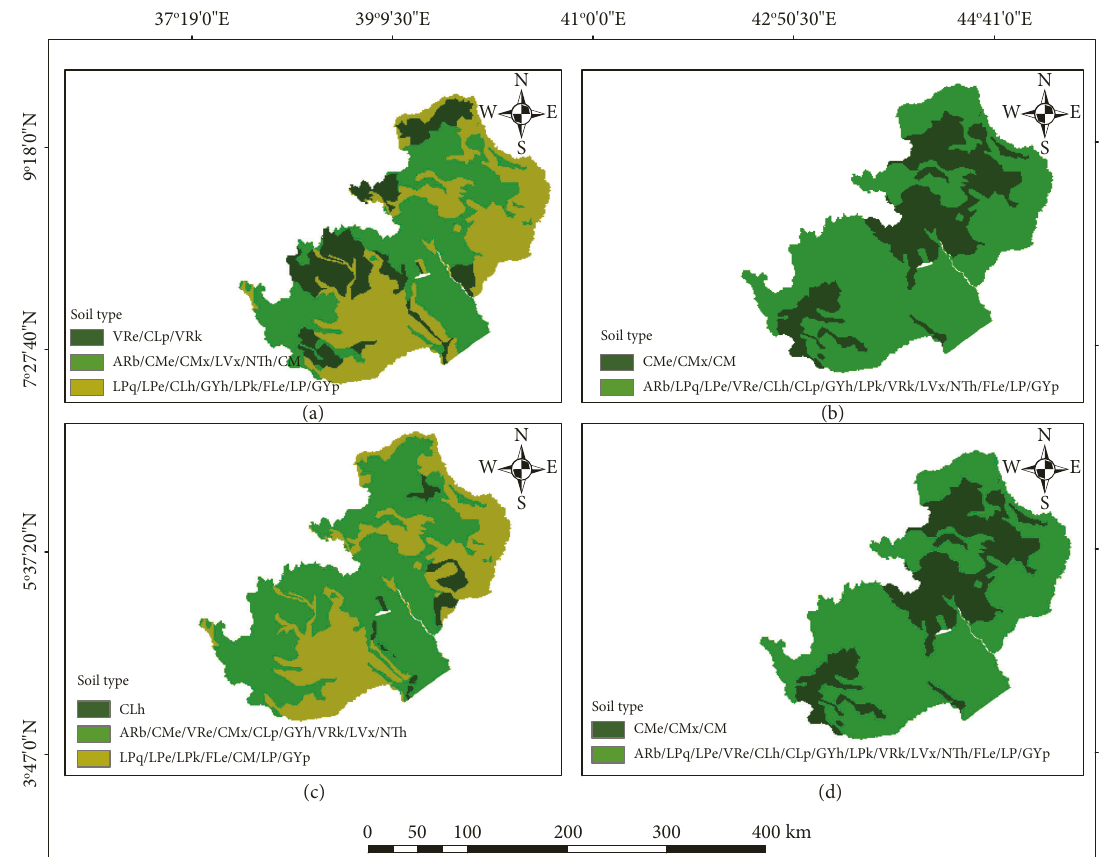
Figure 5: Soil factor map for livestock production: (a) cattle, (b) goat, (c) sheep, and (d)